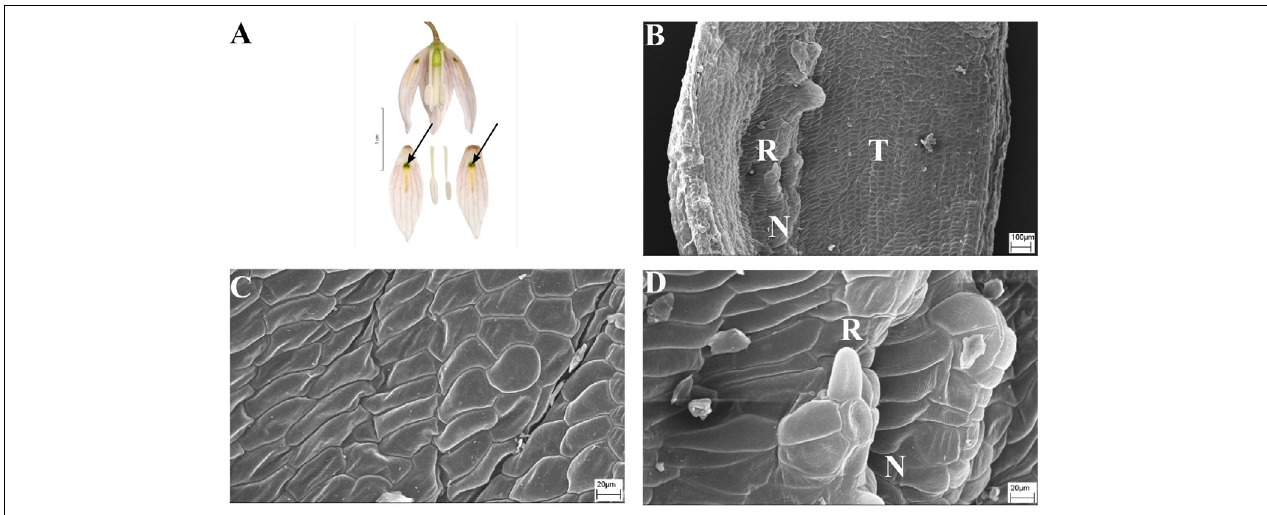
FIGURE 6 | Flowers and nectaries of F. ayakoana . Macro and SEM images. (A) Flowers and tepals, nectaries marked with arrows. (B) Part of outer tepal showing the nectar-bearing area (N) with upwardly curved ridge or protuberance on its surface and slightly convex surrounding area (T). (C) Slightly convex cells of outer tepal surface directly above the nectary. (D) Cuticule of the nectary (N) of outer tepal with protuberance (R).